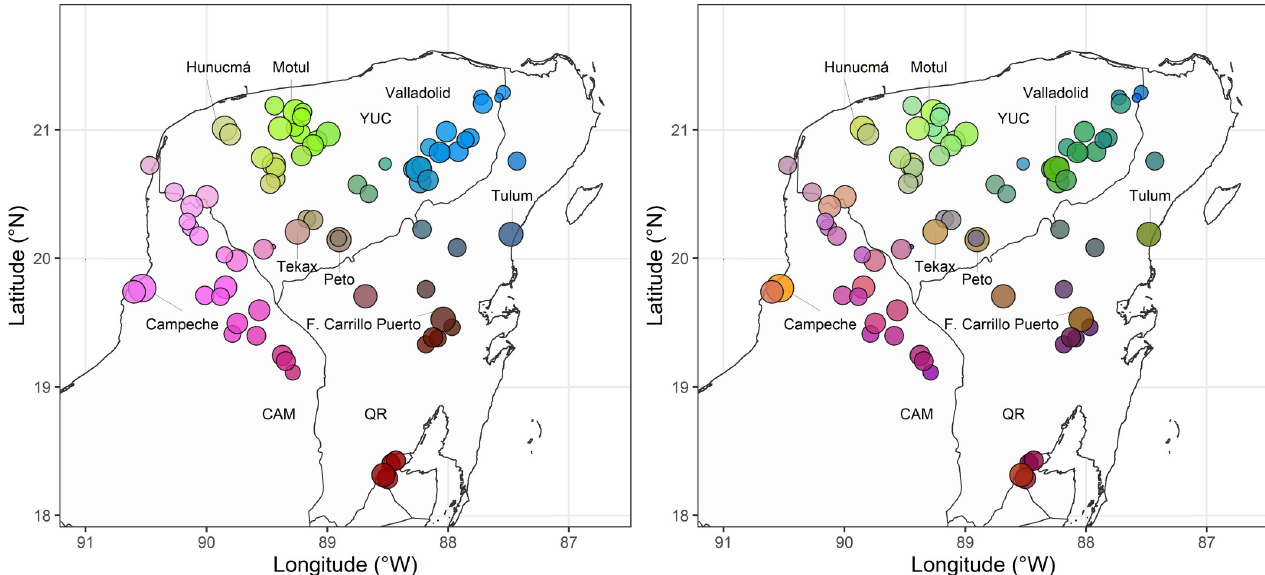
Fig 5. Model predictions. Predicted similarities between locations represented by RGB-Color values. Dot size: Logarithmized population size (the eight largest cities of the sample are labeled). Left Panel: Predictions of the Wave Theory (distance matrix containing the logarithmized distances between locations). Right Panel: Predictions of the Gravity Model (distance matrix containing the logarithmized distances between locations, divided by a distance matrix containing the product of logarithmized population sizes).